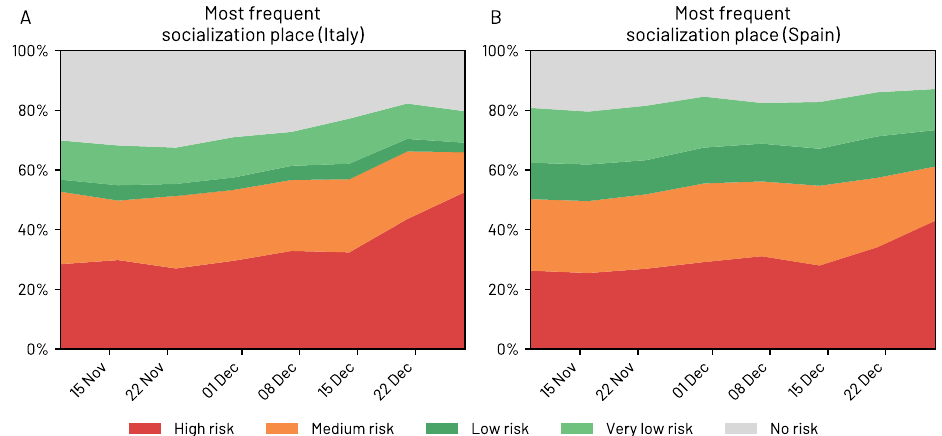
Figure 3. Associated risk of the most frequent place of socialisation for Italy (A) and Spain (B) between November 1st 2020 and December 31st 2020. Note how socialisation in high-risk environments (i.e. indoors without any protection measures) increases over time (red area in the